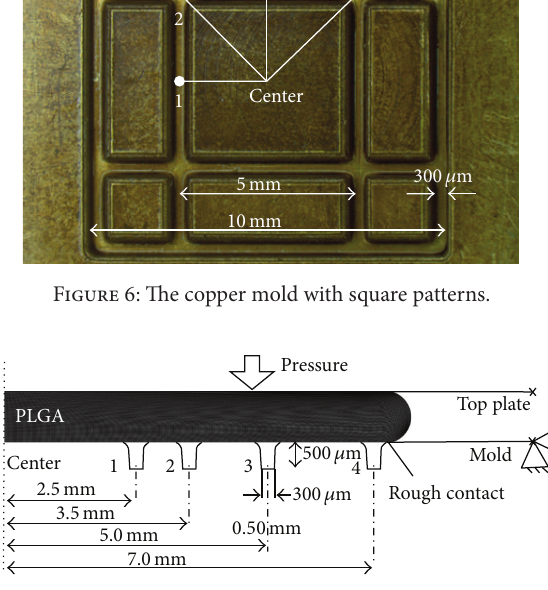
Figure 7: Simplified plane strain model of the